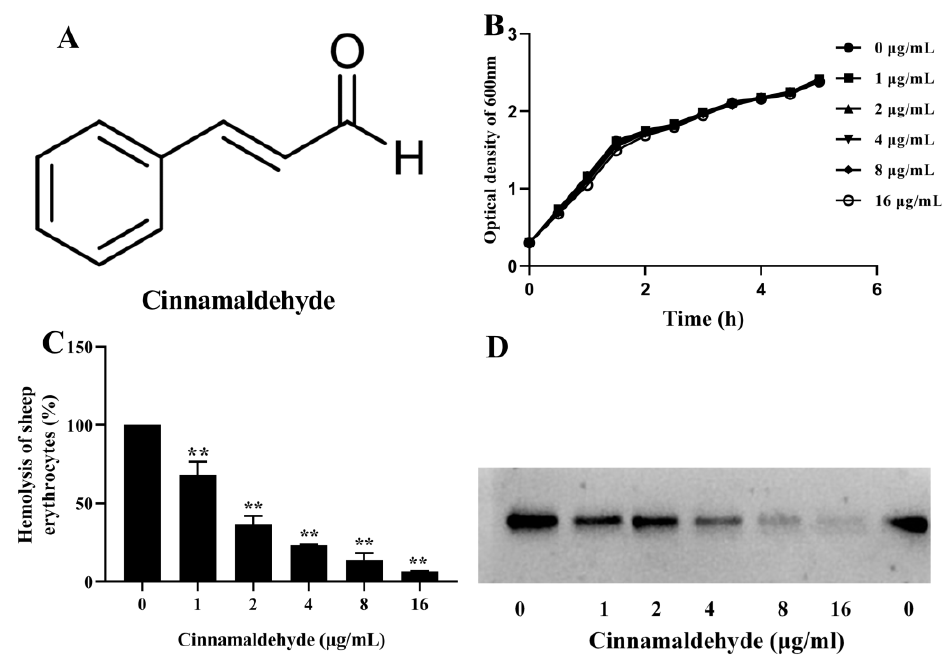
Figure 1. Inhibitory effects of cinnamaldehyde on hemolytic activity induced by aerolysin. ( A ) Chemical structure of cinnamaldehyde; ( B ) growth curves of A. hydrophila co-cultured with indicated concentrations of cinnamaldehyde; ( C ) effect of cinnamaldehyde on the hemolytic activity of bacterial supernatants; sheep erythrocytes treated with the bacterial supernatant of the drug-free group were used as the positive control; ( D ) detection of aerolysin production in bacterial supernatant plus cinnamaldehyde. The hemolysis assays in Figure 1C consist of data from three independent experiments. The results shown are the mean ± SD of the three experimental data compared to the drug-free group, **, p < 0.01.